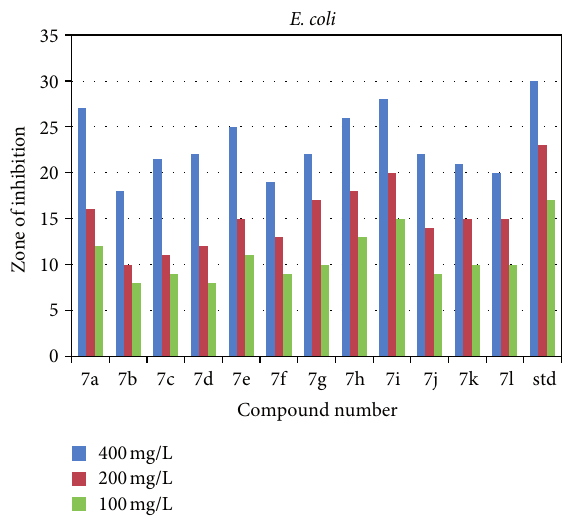
F 2: Antibacterial activity against E. coli